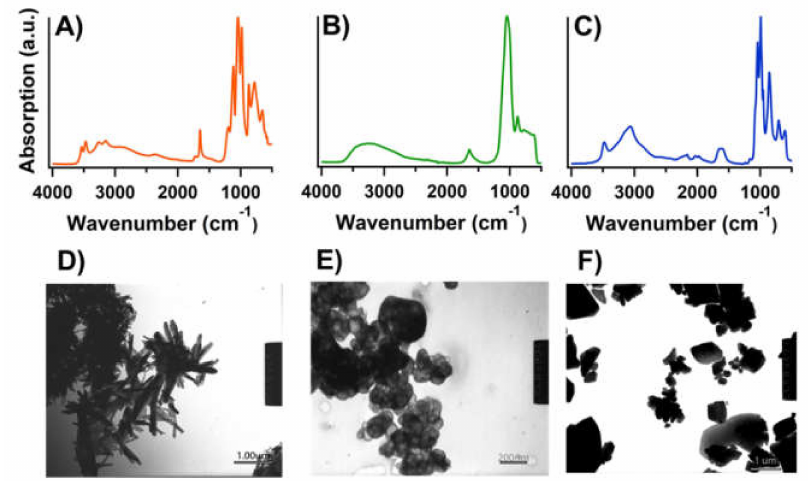
Figure 4. ATR-FTIR (top) and TEM images (bottom) of the apatite / bobbierite series: ( A , D ) pure hydroxyapatite, ( B , E ) hydroxyapatite / amorphous calcium phosphate formed from 5:1 (Ca:Mg) initial solution conditions, ( C , F ) pure bobierrite. Larger versions of ATR-FTIR spectra are available in the Supplementary information.